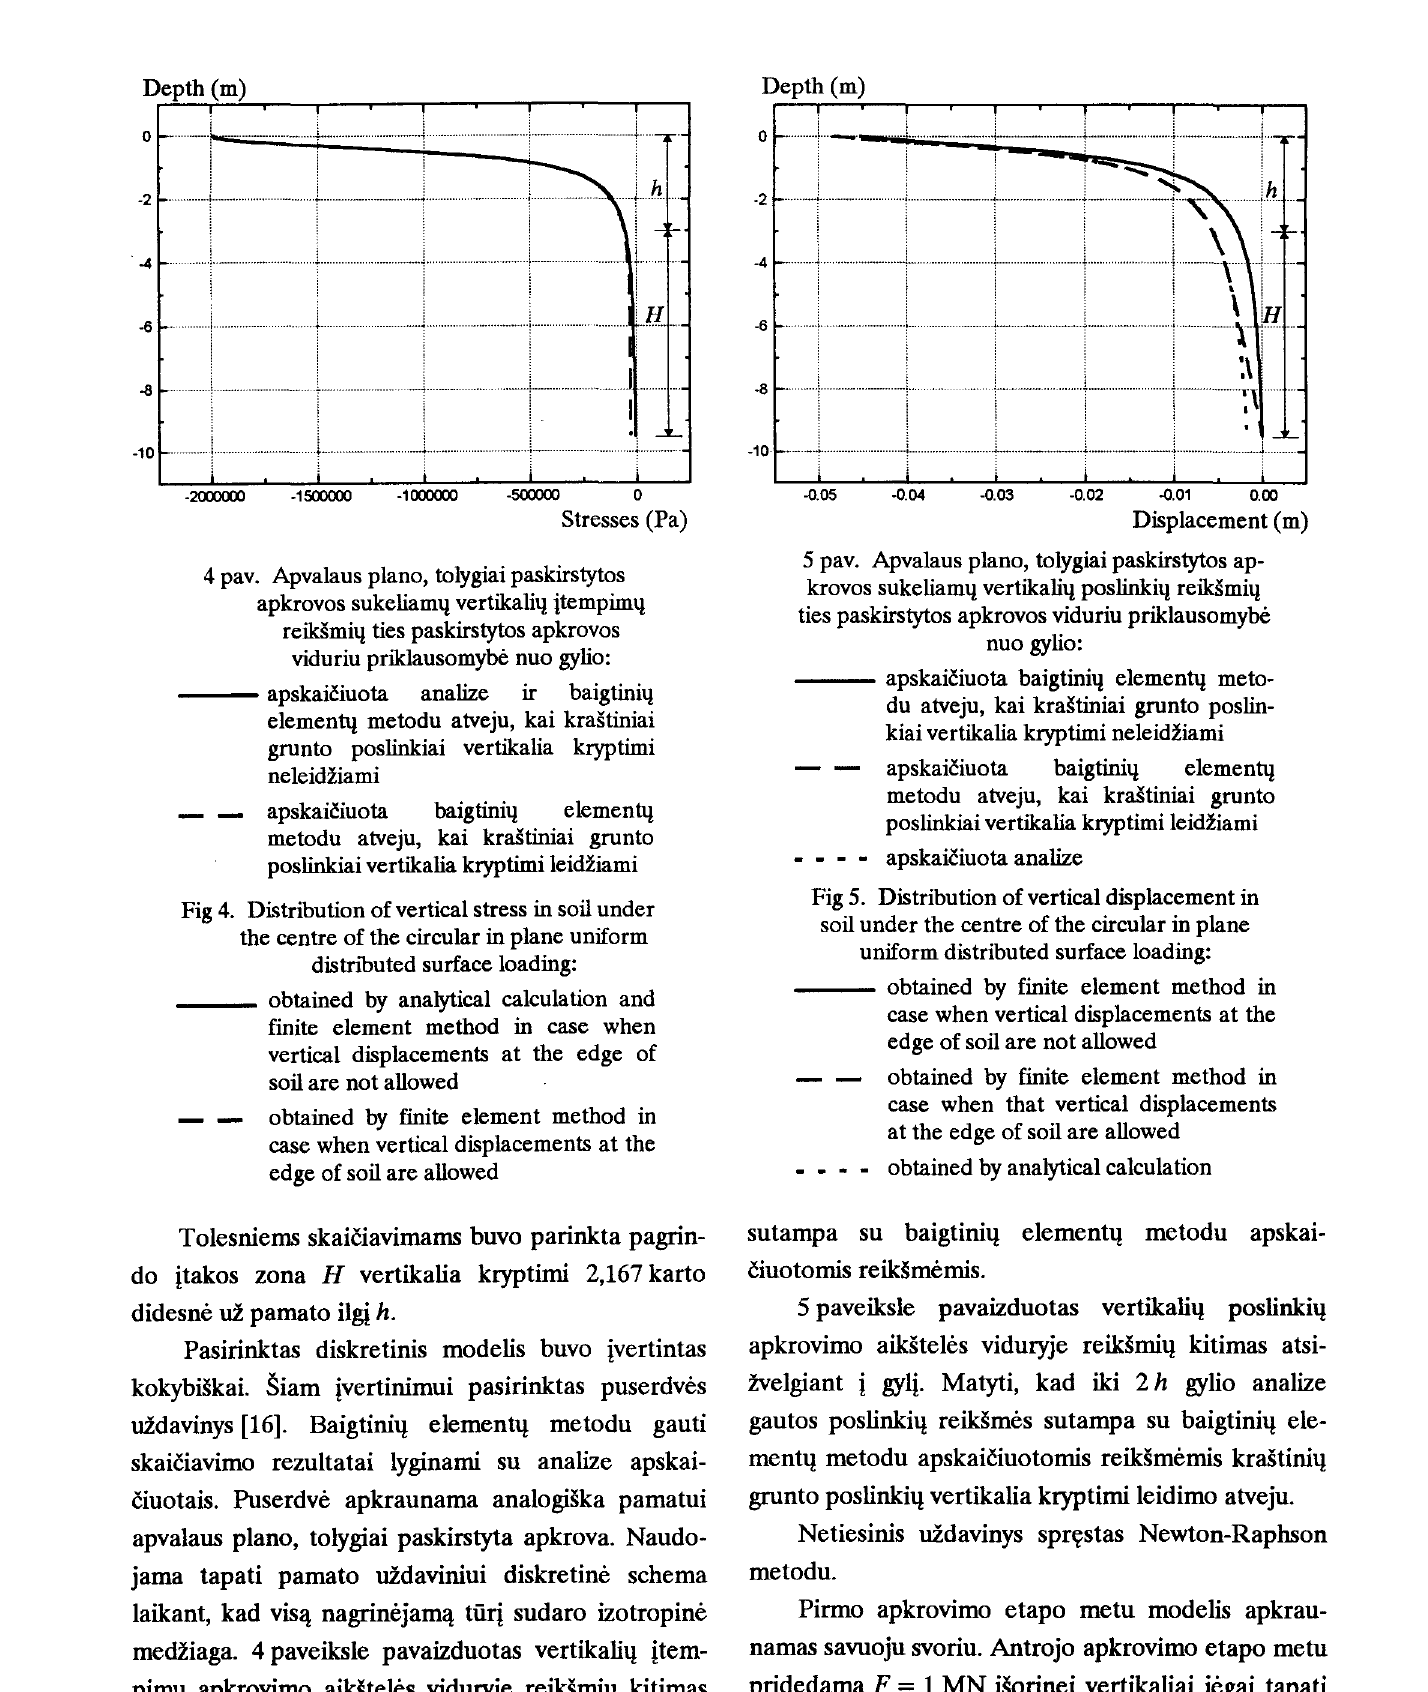
Fig 4. Dic;tribution of vertical stress in soil under the centre of the circular in plane uniform distnbuted surface loading: